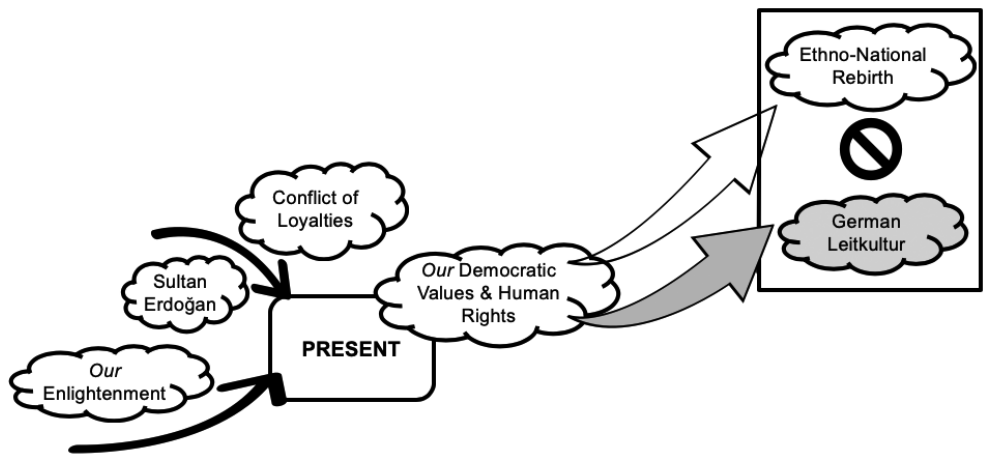
Figure 8. Stage III comedy-romance story with two happy endings, racial (white) and cultural (grey) boundaries. Social Inclusion, 2020, Volume 8, Issue 1, Pages